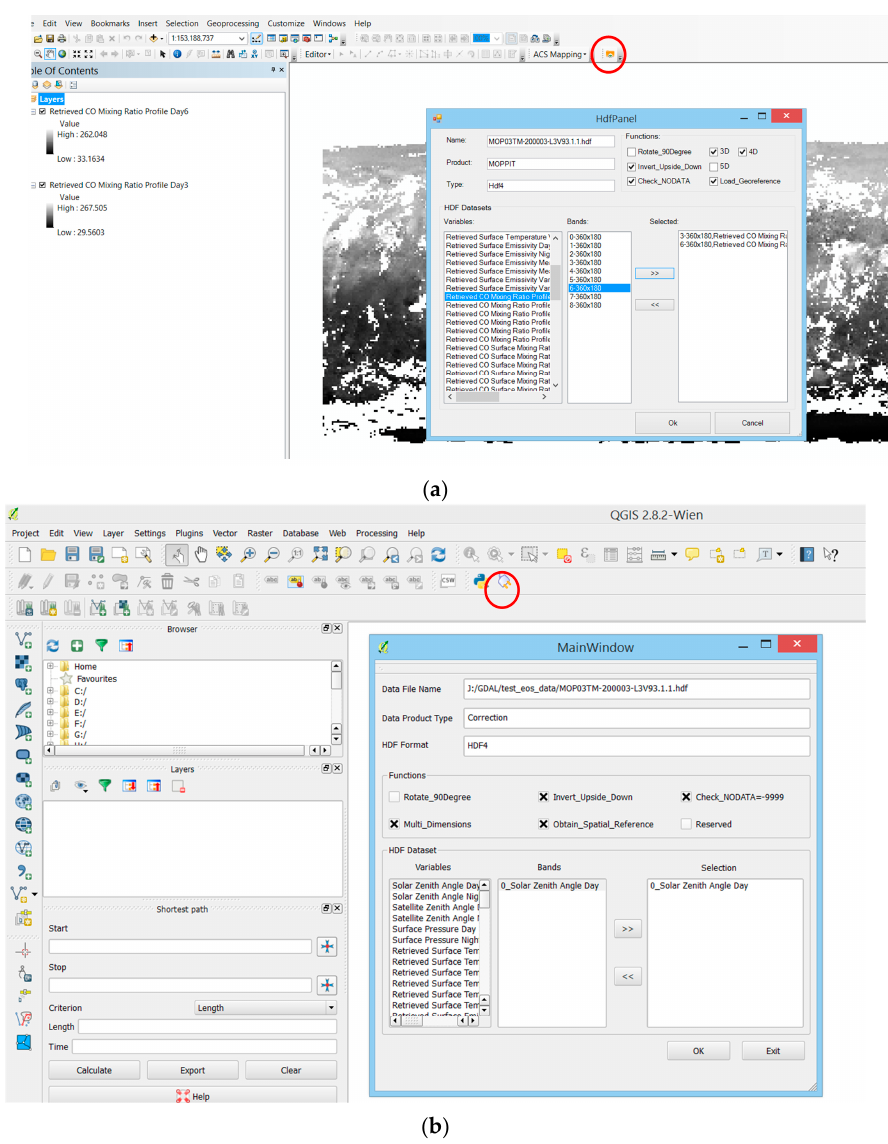
Figure 9. GUIs of ArcGIS ( a ) and QGIS ( b ) extensions incorporating the proposed framework